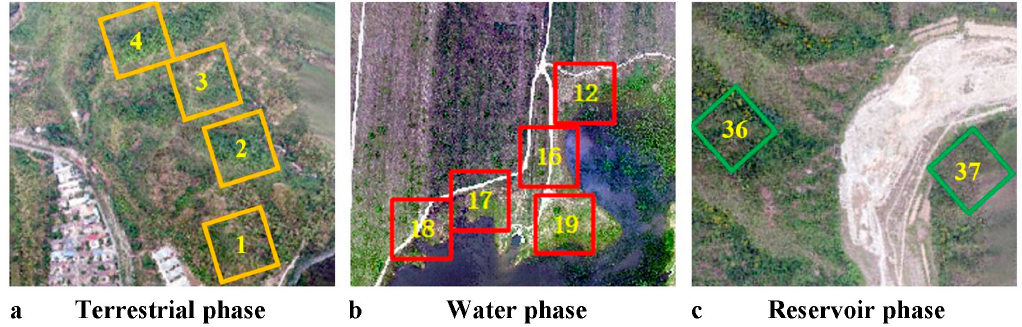
Figure 3. Examples of the in situ quadrants in different phases. ( a ) Quadrants selected in the terrestrial phase; ( b ) quadrants selected in the water phase; ( c ) quadrants selected in the reservoir